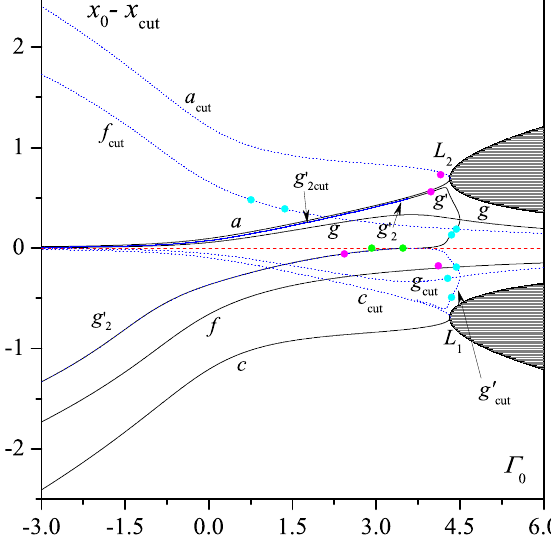
Figure 6. The full chart of the basic families of planar periodic orbits of the Hill problem where both the positive (black continuous lines) and negative (blue dotted lines) crossings of the orbits with the O x -axis are presented. Forbidden regions to motion are shown grey while red dashed line stands for the position of the secondary. Cyan, green and magenta dots represent the planar termination orbits of the spatial families.